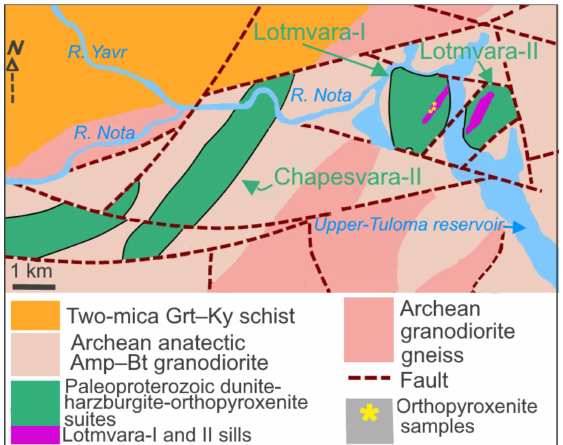
Figure 3. Schematic geological map shows the regional geology, modified slightly from [16], with the position of the sills of Lotmvara-I and II, which are based on the results of our mapping. The location of the sampling area is shown by a yellow star symbol, which corresponds to the orthopyroxenite zone of the Lotmvara-I sill.